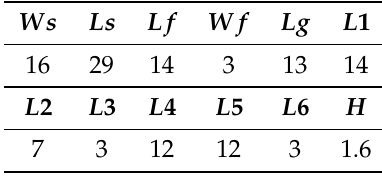
Table 1. The parameters of the optimized antenna (unit: mm). (the bold words in the first and the third row represent the parameters, the second and the fourth row represent the value of the corresponding